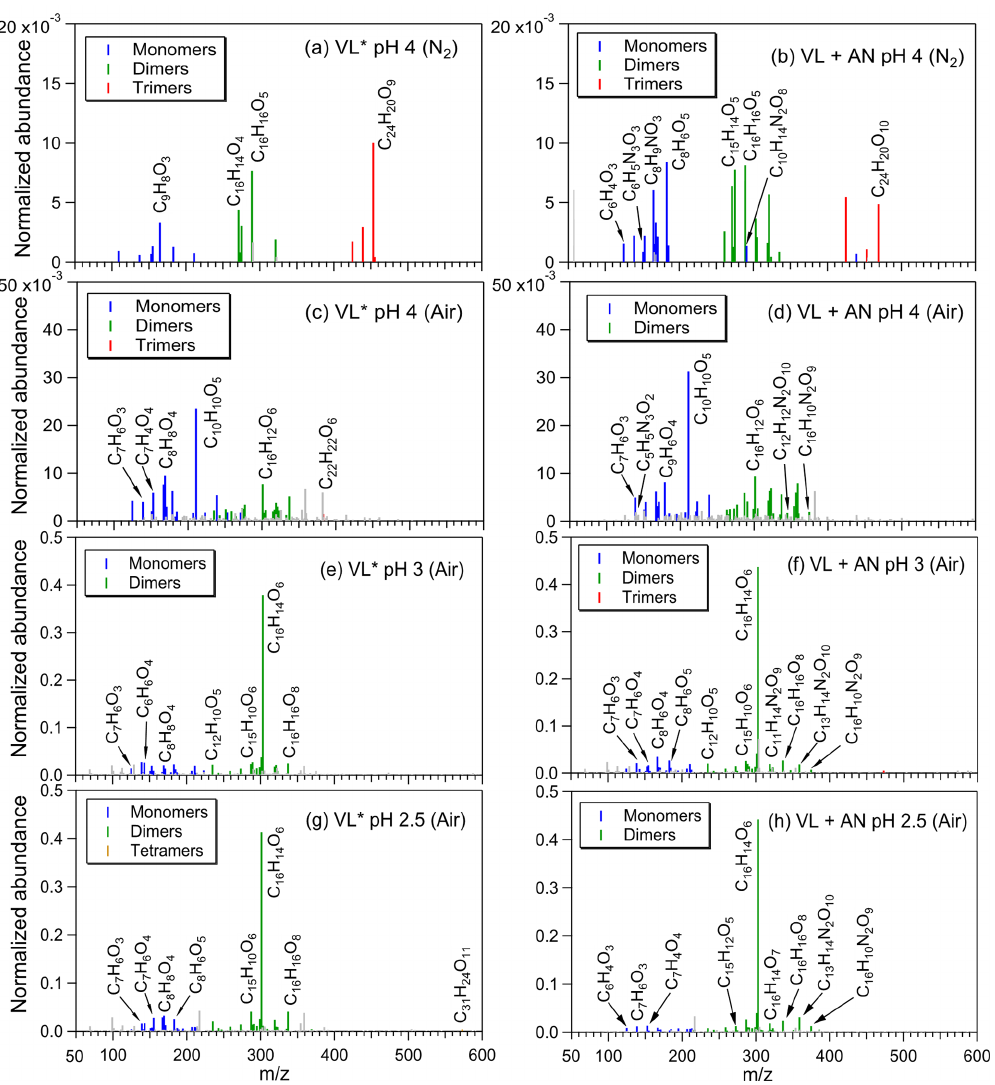
Figure 1. Reconstructed mass spectra of assigned peaks from (a) VL ∗ pH 4 (N 2 saturated; A6), (b) VL + AN pH 4 (N 2 saturated; A8), (c) VL ∗ pH 4 (air saturated; A5), (d) VL + AN pH 4 (air saturated; A7), (e) VL ∗ pH 3 (air saturated; A3), (f) VL + AN pH 3 (air satu- rated; A4), (g) VL ∗ pH 2.5 (air saturated; A1), and (h) VL + AN pH 2.5 (air saturated; A2) after 6h of simulated sunlight irradiation.